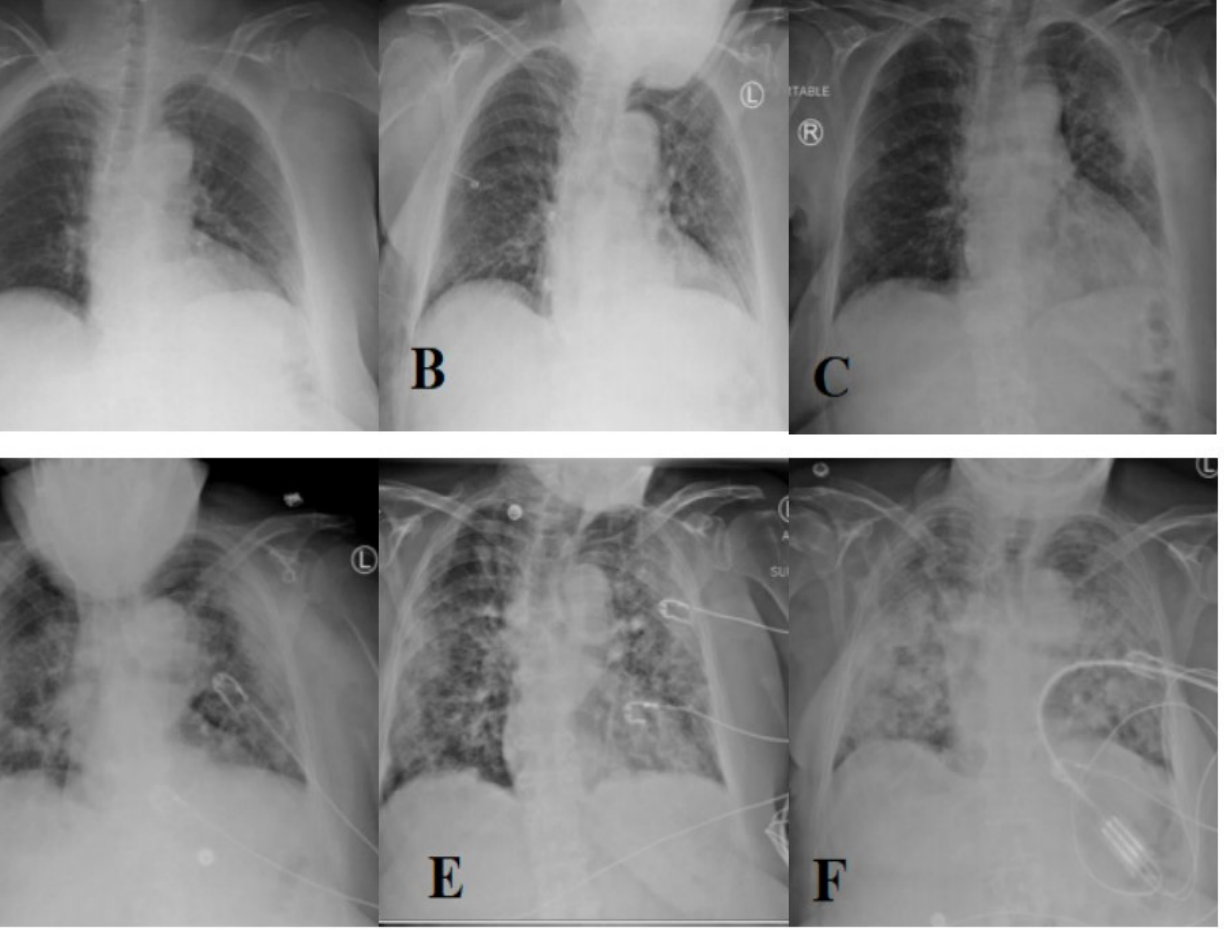
Figure 1. Evolution of an X-ray image for a COVID-19 patient over days (1 ( A ), 3 ( B ), 6 ( C ), 7 ( D ), 8 ( E ), and 10 ( F ), respectively) [11] (reproduced with permission).